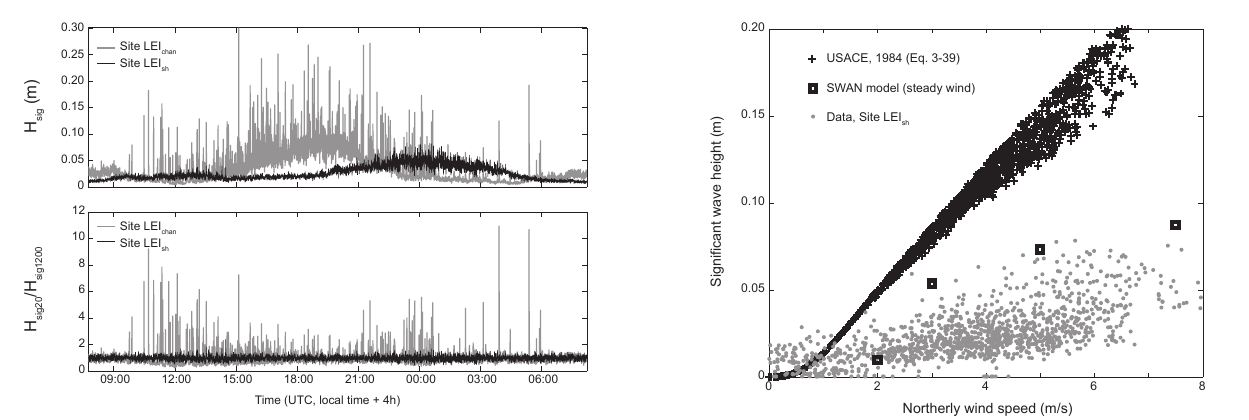
Figure 11. Measured and modeled wave-height response to wind at site LEI sh ; the USACE formulation neglects spatial variation in bathymetry and the SWAN model does not include the influence of tidal currents and assumes a constant, uniform wind